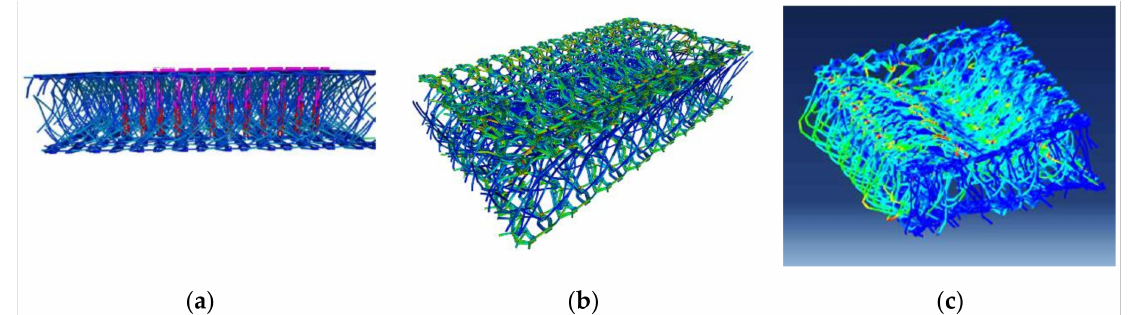
Figure 11. ( a ) “3D sewing” and spacer fabric with a seam. A seam-yarn is integrated into the spacer structure of the fabric under pre-strain; ( b ) TexMath simulation of the compression of the spacer fabric under this pre-strain; ( c ) ABAQUS simulation for large